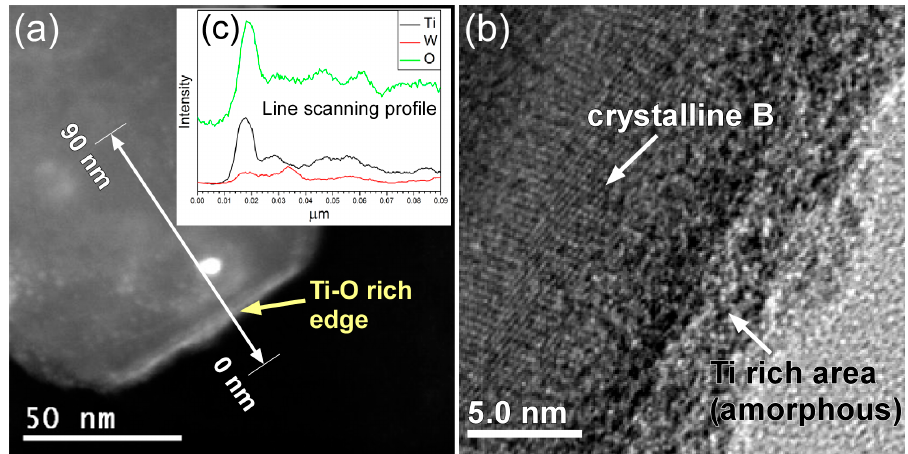
Figure 8. Analysis of an 8 h wet-milled boron particle: ( a ) Scanning transmission electron microscopy/high-angle annular dark field (STEM/HAADF) image. EDX line scanning analysis was performed as indicated by the green line; ( b ) High resolution TEM image of the particle; and ( c ) STEM/EDX line scanning results for the 8 h wet-milled boron particles.